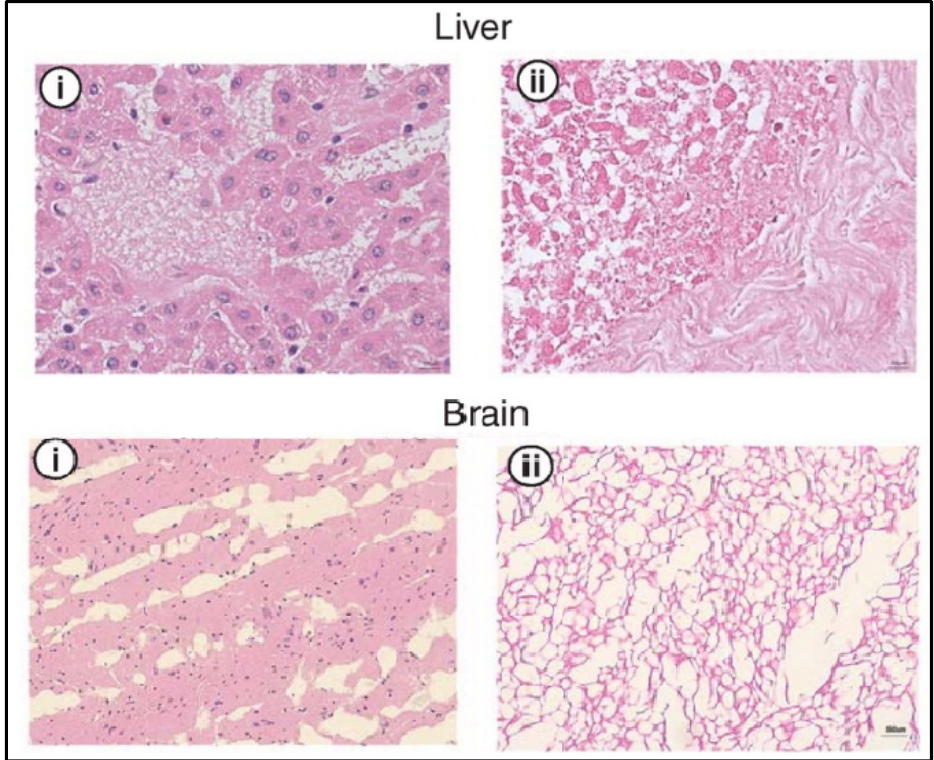
Figure 5. H&E analysis of the liver and brain before ( i ) and after decellularization ( ii ) with SCCO 2 . Cellular nuclei stained blue. Adapted from